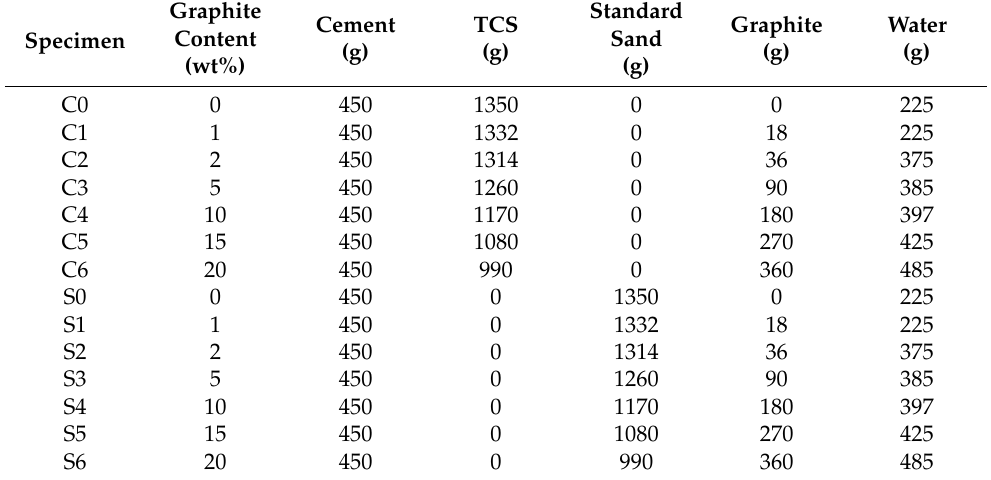
Table 1. Mix proportion of graphite–cement